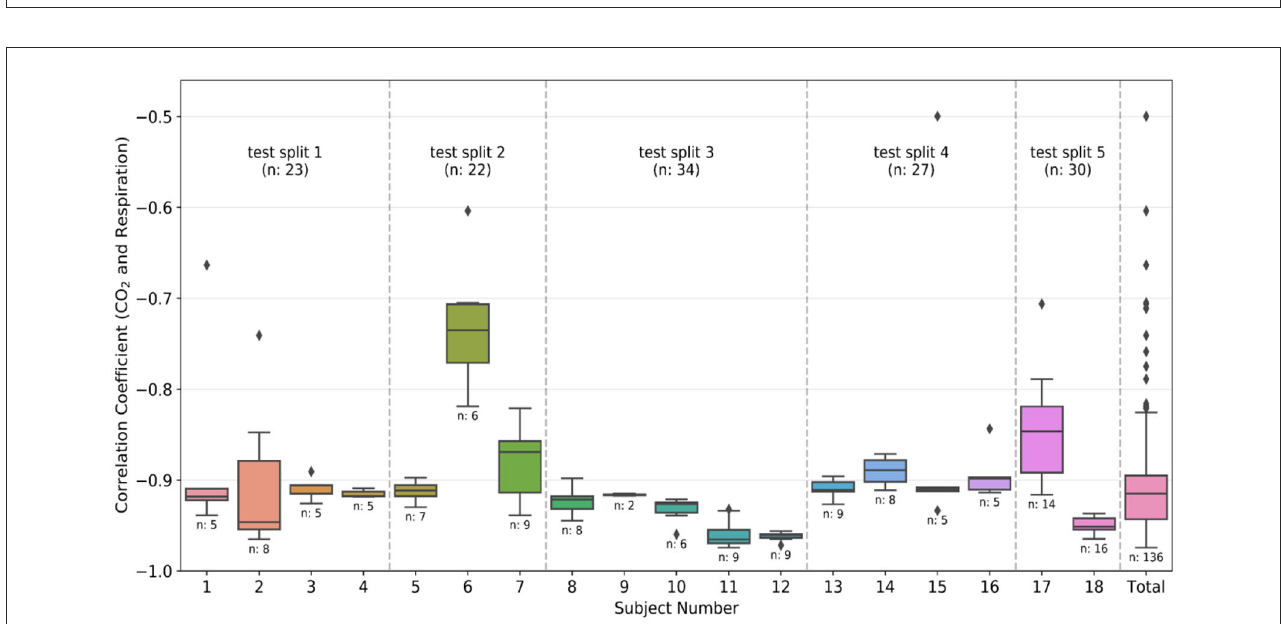
FIGURE2 Quality assurance metrics: Box plots of the correlation coefficient between CO 2 and respiration waveforms from each individual subject and the total data after preprocessing. The number of recordings available for each subject is also given below the box plot. The divisions created by the dashed line show the groups made during the k-fold split of the dataset. The group number is the same as the test split number, and the total number of recordings in the group is also provided in the plot. The color-coding is the same as Figure 1.